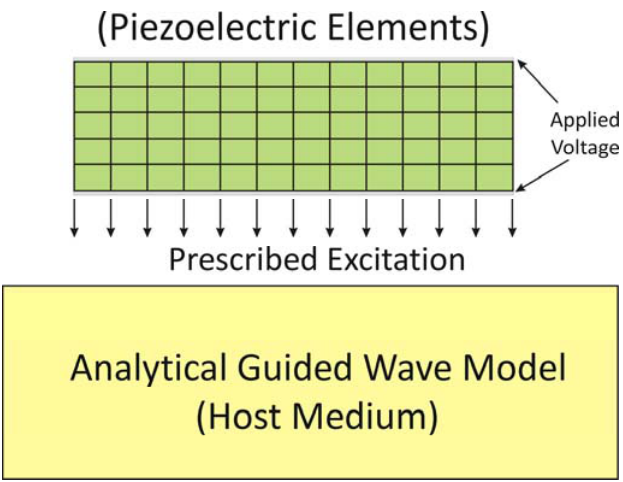
Figure 9. Illustration of the scheme of the hybrid